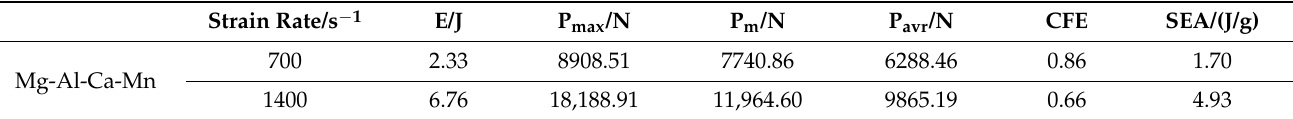
Figure 8. P-s curves of the Mg-Al-Ca-Mn alloy under high strain rate compression in the ED direction. Table 6. Energy absorption of Mg-Al-Ca-Mn alloy under the high strain rate compression in the ED direction.